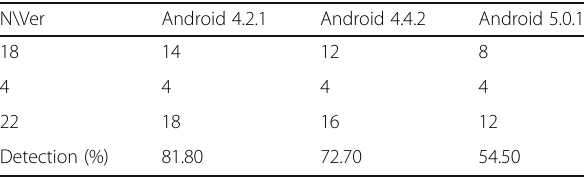
Table 3 Detection results of unknown